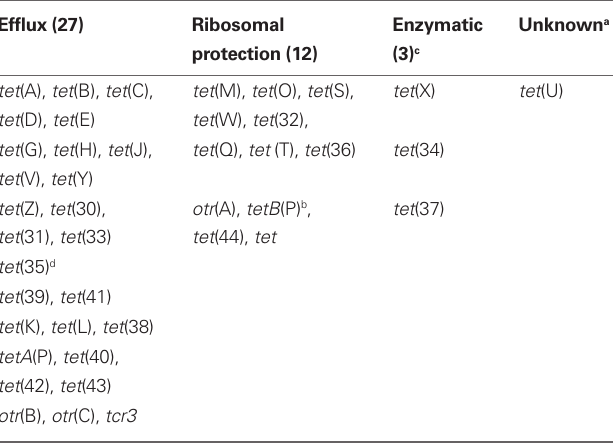
Table 2 | Mechanism of resistance of tet and otr